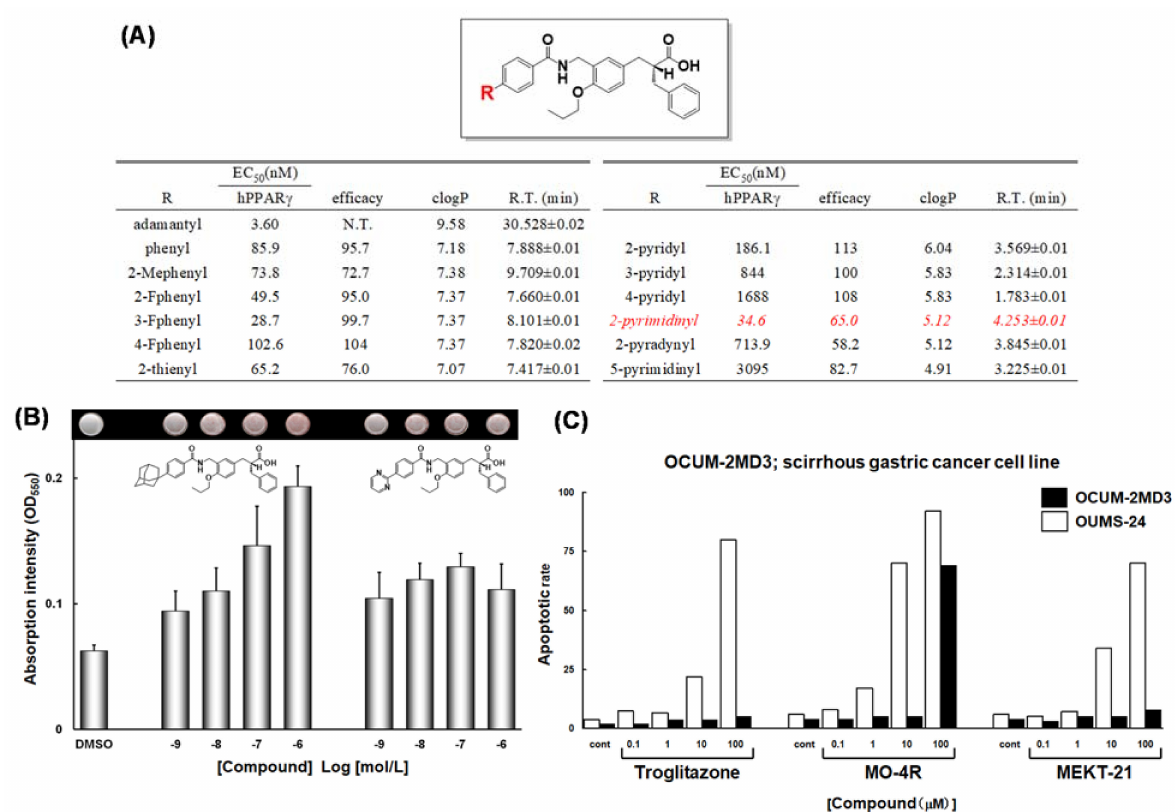
Figure 18. ( A ) PPAR γ agonist activities of a series of compounds. ( B ) Adipogenesis-inducing activity of MO-4R and MEKT-21. After pretreatment with 1 l M Dex, 0.5 mM IBMX, and 5 µ g/mL insulin, 3T3-L1 cells were incubated with the indicated concentrations of MO-4R and MEKT-21. Oil red O-stained cells are shown at the top and are quantified at the bottom by measurement of OD550 ( ± SD). ( C ) Apoptosis-inducing activity of troglitazone, MO-4R and MEKT-21 in OCUM-2MD3 and OUMS-24